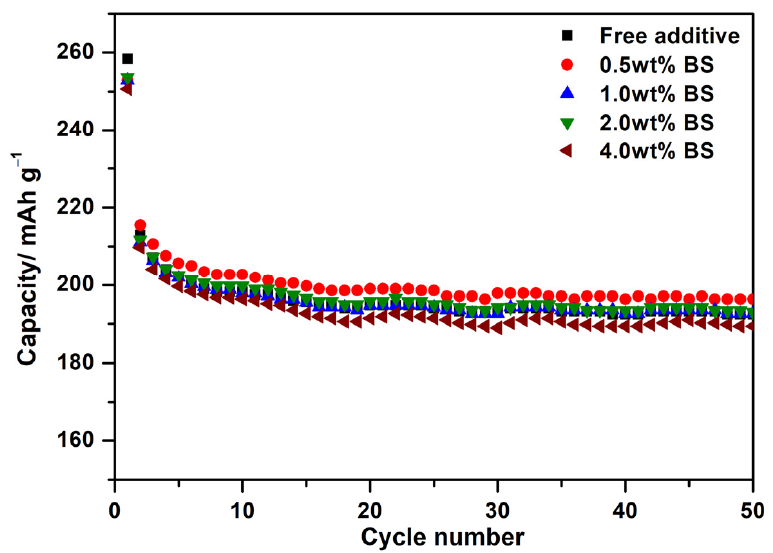
Figure 1. Cycling performances of LTO electrodes with the electrolytes containing di ff erent BS lower the impedance value, the more rapid the transportation of the Li-ion through the concentrations at the 0.2 C-rate. SEI film.